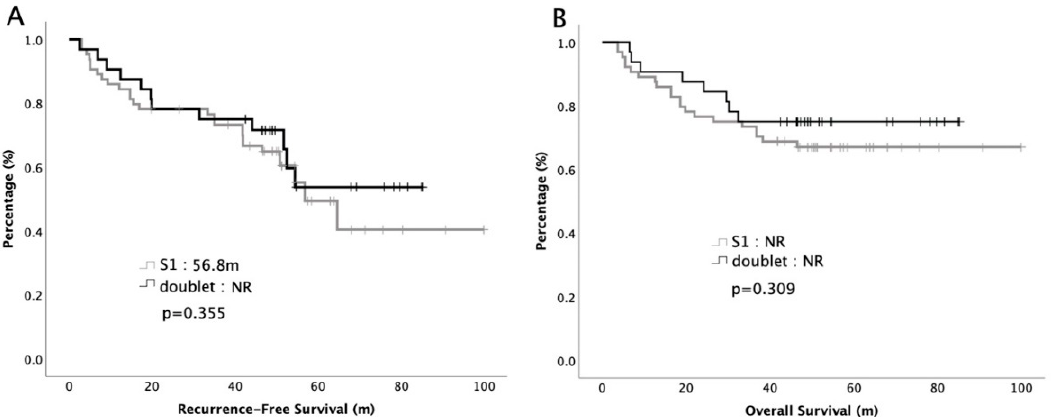
Figure 1. Recurrent-free survival ( A ) and overall survival ( B ) of 128 patients with advanced gastric cancer receiving adjuvant chemotherapy.